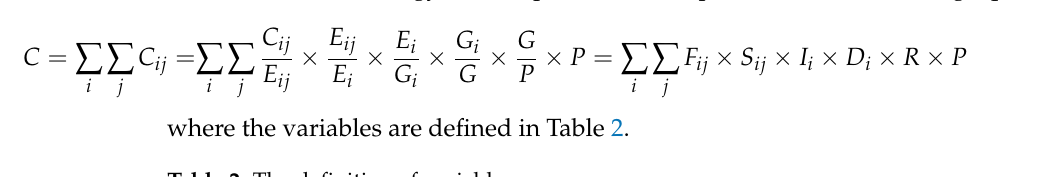
Table 2. The definition of